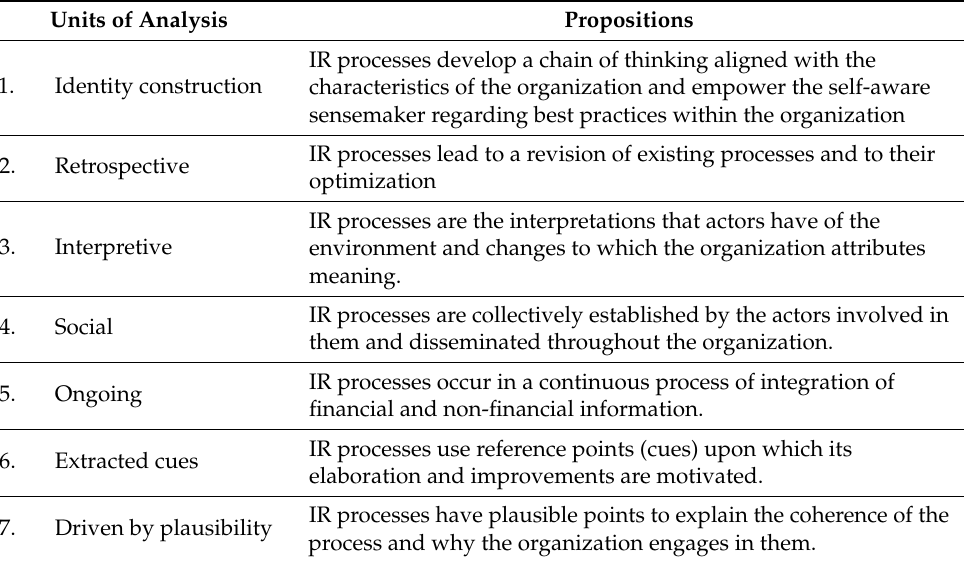
Table 5. Propositions for empirical identification of the sensemaking